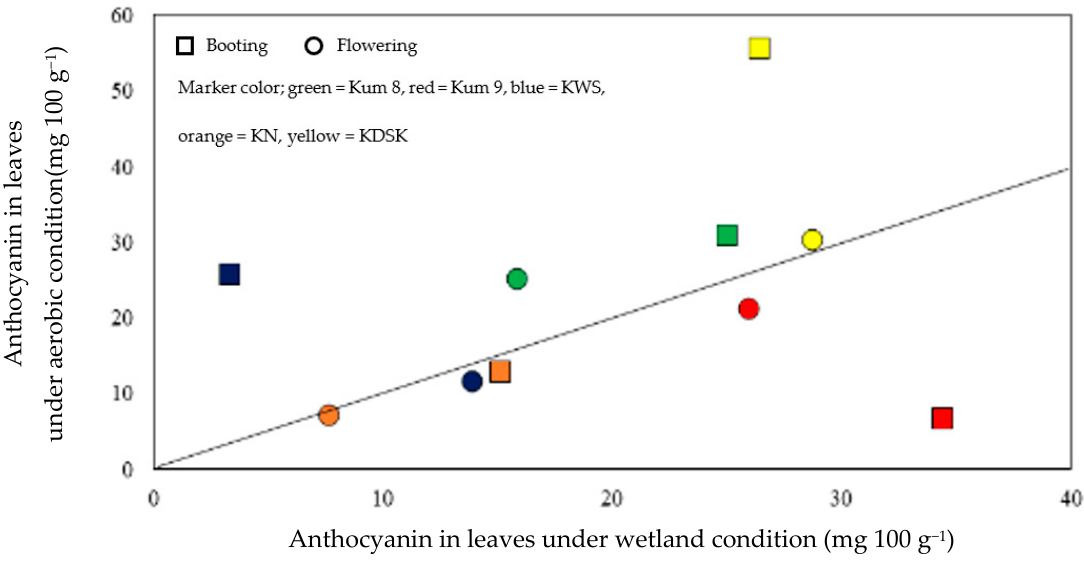
Figure 3. Comparison of anthocyanin in leaves at booting and flowering stages of 5 purple rice varieties grown under waterlogged compared with aerobic condition. Each data point is the mean of 3 replications.